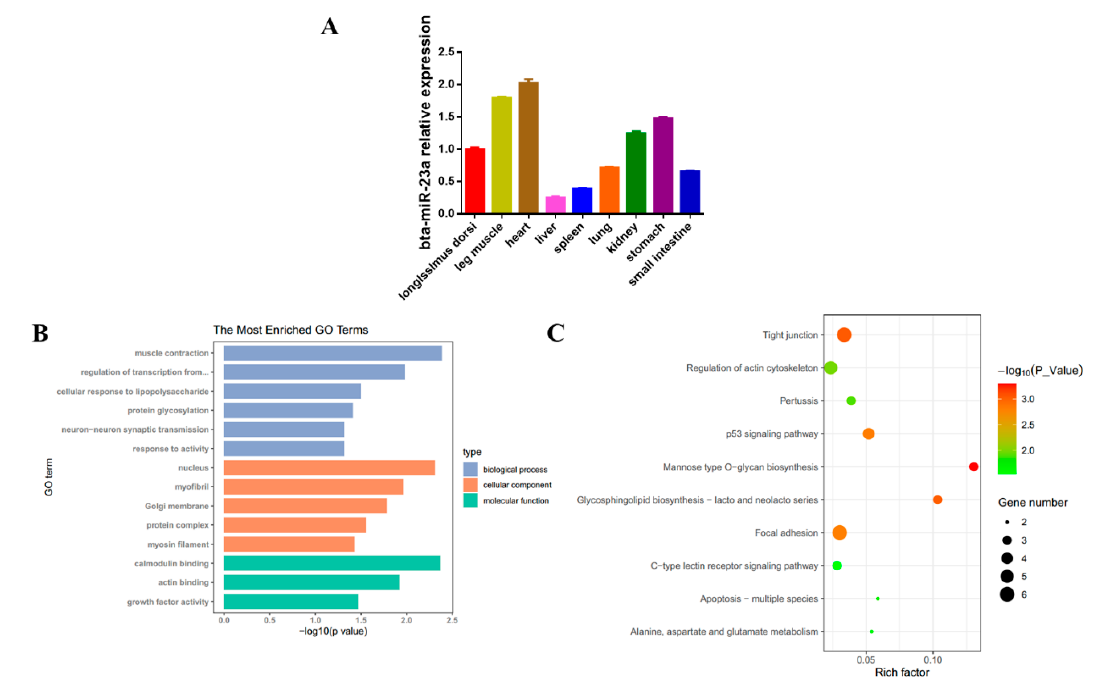
Figure 1. bta-miR-23a expression profile and its targets analysis. ( A ) Tissue expression of bta-miR-23a examined by qPCR in fetal tissues. The fold change of bta-miR-23a was relative to bta-miR-23a expression of longissimus dorsi. ( B ) GO term enrichment of target genes for bta-miR-23a. ( C ) KEGG pathway analysis of target genes for bta-miR-23a. Results are representative of the mean (± SD) of three independent analyses.